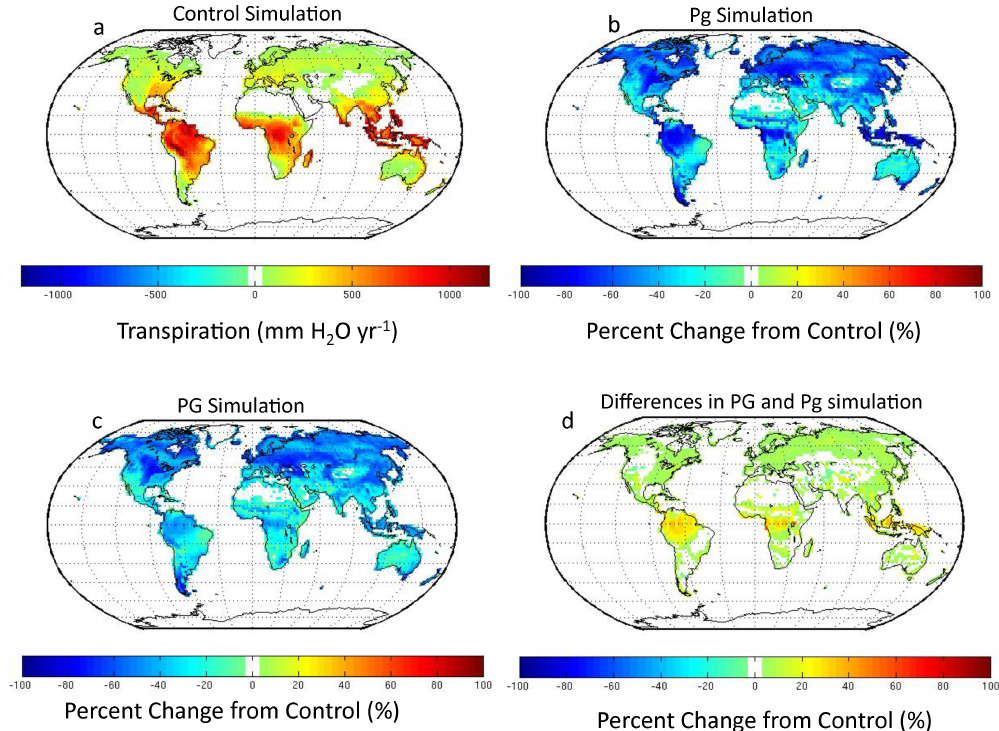
Fig. 4. Mean annual transpiration predicted in 20-yr CLM simulations run at 100ppb O 3 . The control simulation (a) shows the average amount of water lost via transpiration annually in the absence of O 3 . The percent changes from control were mapped for the (b) Pg simu- lation, where a direct change in photosynthesis causes indirect changes in conductance and for the (c) PG simulation, where direct changes to photosynthesis and conductance occur independently. Panel (d) illustrates the differences in transpiration between the PG simulation compared to the Pg simulation, also mapped as a percent change from